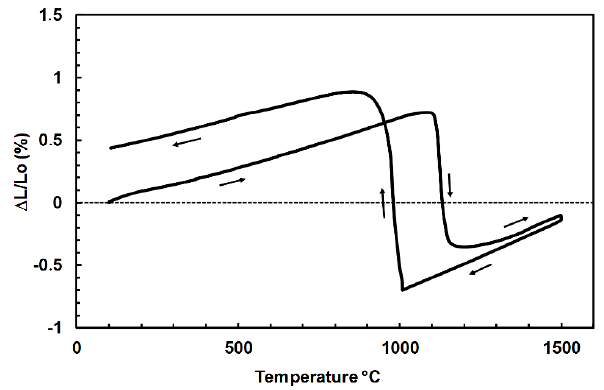
Figure 4. Unconstrained thermal expansion curve of the ZrO 2 -SiO 2 refractory.